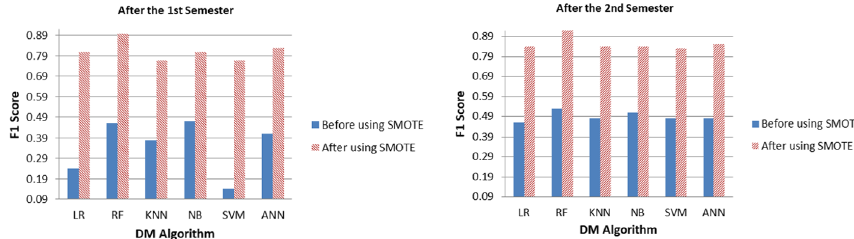
Fig. 5 A comparison between the achieved F1 scores for the minority class (Not_completed) using DM methods with and without